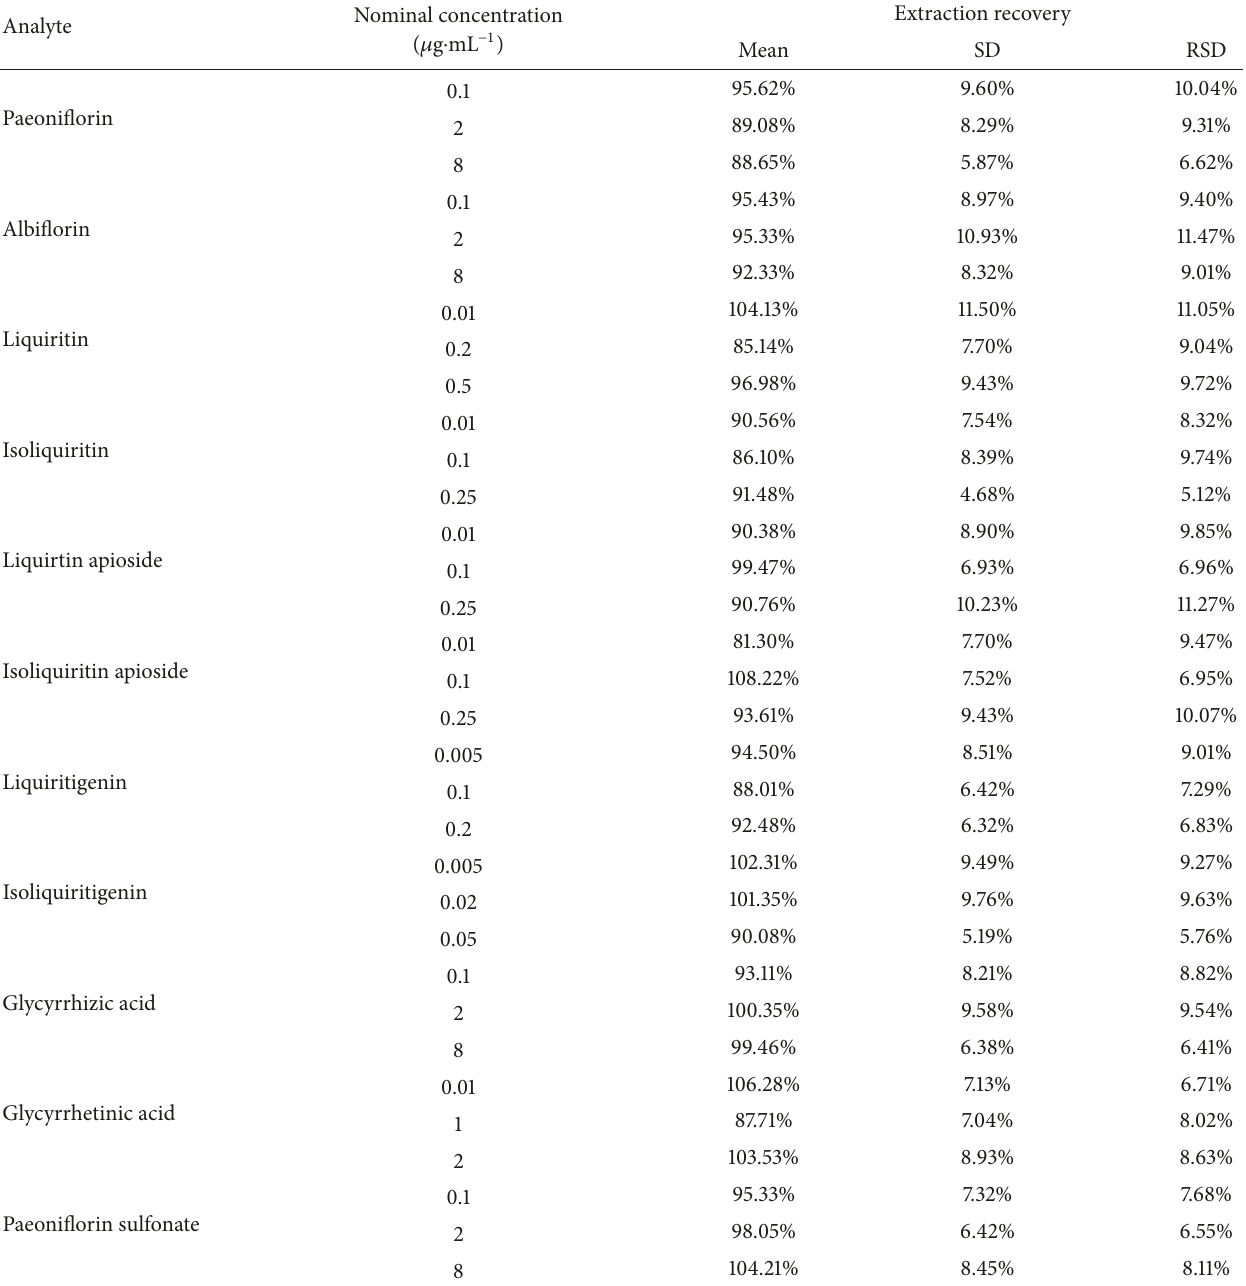
Table 6: The extraction recovery of detected compounds in rat plasma ( 𝑛 = 6